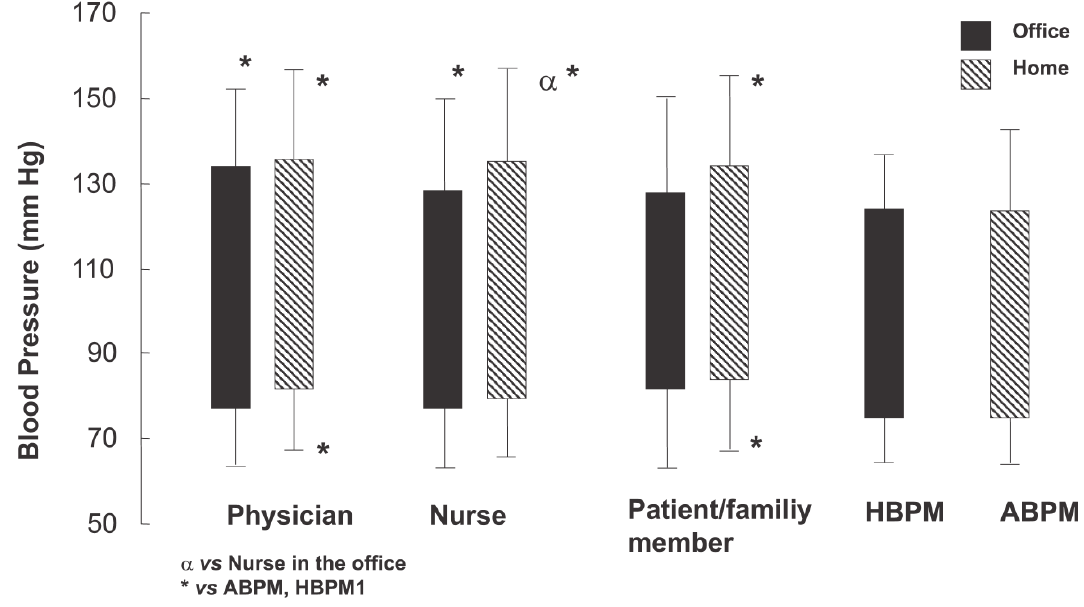
Figure 2 – Blood pressure measurement in office and during a regular home visit (Home 1) taken by patients/family member, physicians, and nurses compared with Ambulatory Blood Pressure measurement (ABPM) and Home Blood Pressure Measurement